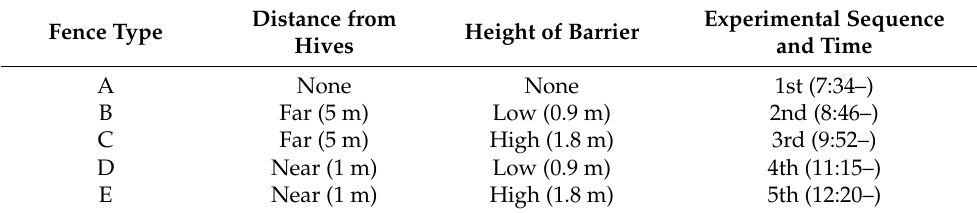
Table 1. Fence type and experimental sequence.